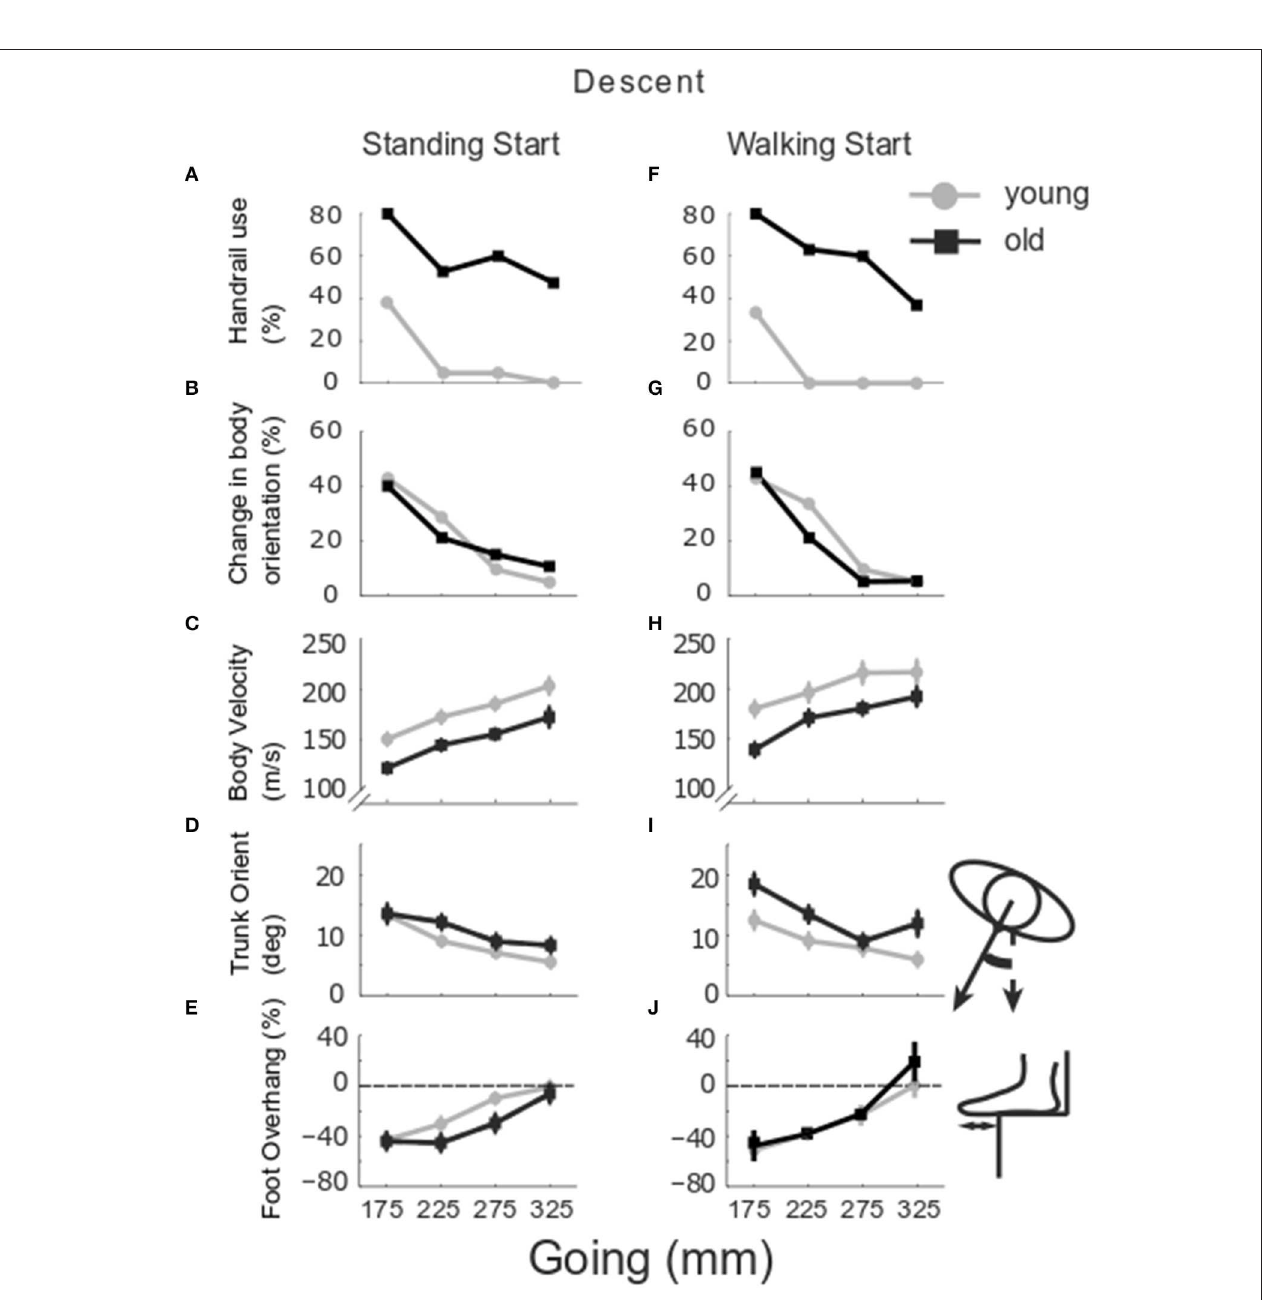
FIGURE 6 | these data are reported. Results are reported for standing start (left column) and walking start (right column). Standing start. Lead foot clearance in the horizontal direction for going of 175mm for younger participants relative to balance score on one leg (A) and balance eyes closed over eyes open (B) . Lead foot vertical clearance for going of 175mm for older participants relative to hours of physical activity (C) and for going of 325mm relative to balance eyes closed over eyes open (D) . Walking start. Lead foot clearance in the horizontal direction for going of 325mm for older participants relative to hours of physical activity (E) . Clearance for going of 175mm for younger participants relative to balance eyes closed over eyes open (F) and at going of 275mm relative to balance score on one leg (G) . Lead foot vertical clearance for older participants relative to hours of physical activity for going of 275mm (H) and for going of 275mm (I) . For each panel a least square fit line and the R 2 values are reported.